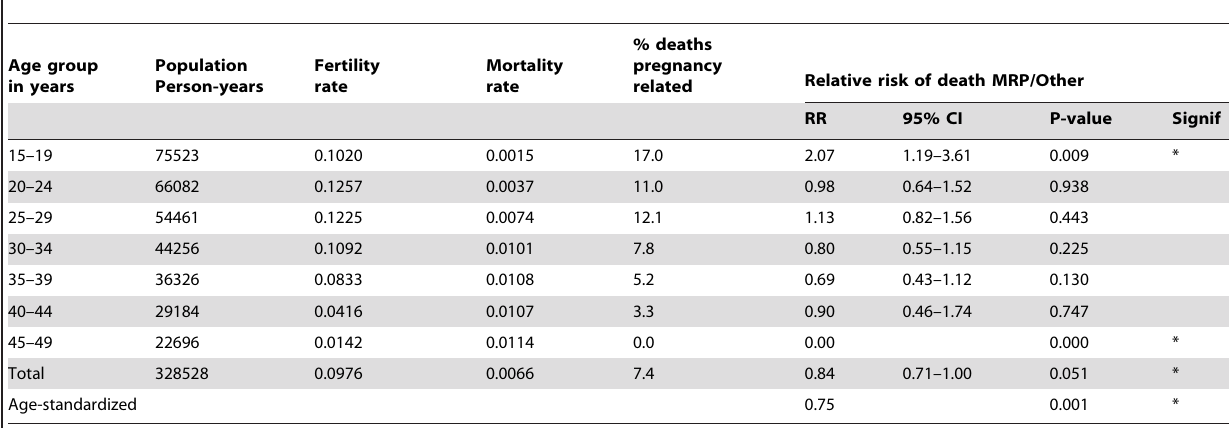
Table 1. Age specific fertility, mortality, and pregnancy related deaths, Agincourt, South Africa,